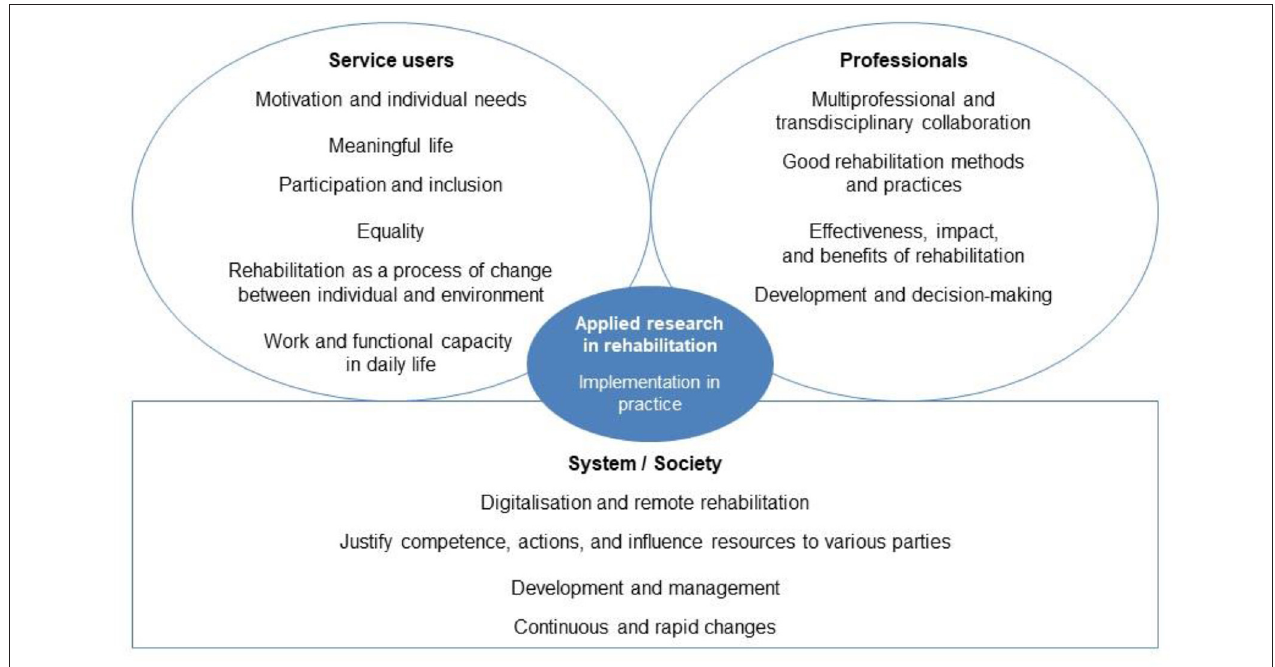
FIGURE 2 | Current and future knowledge needs in rehabilitation